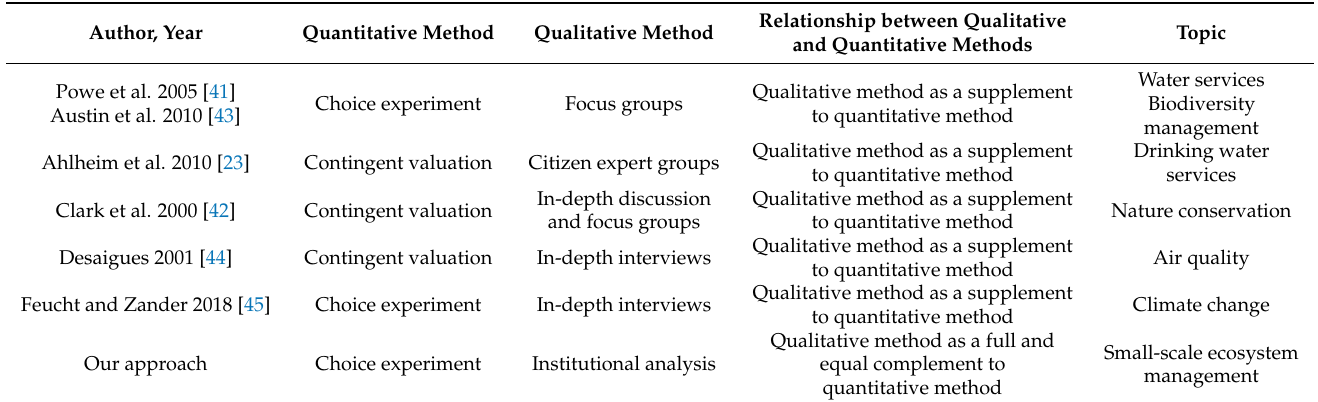
Table 1. Forms of mixed-method research containing willingness-to-pay concerns (source: